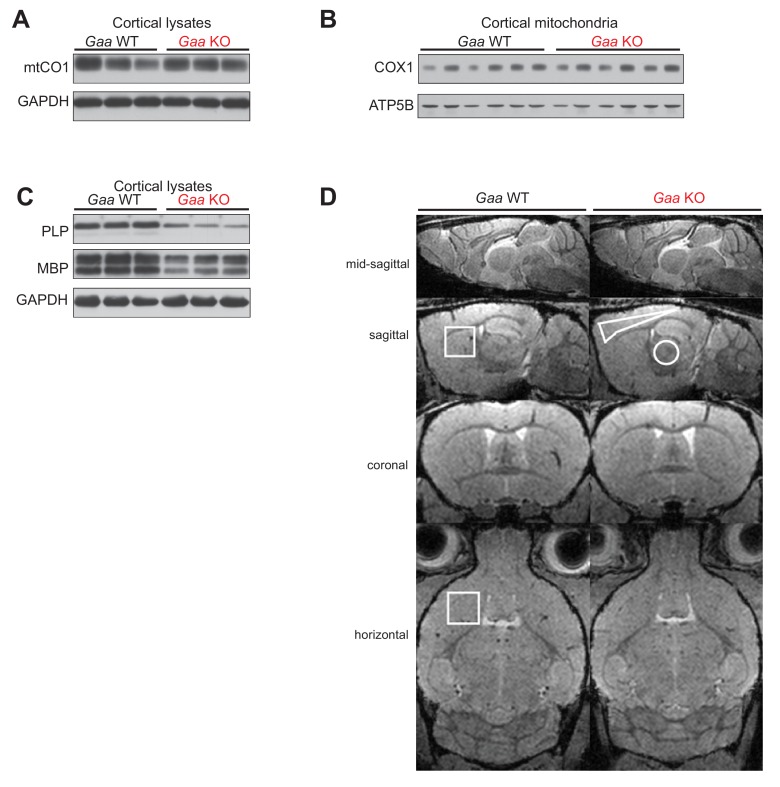
Steady state levels of COX1, PLP and MBP proteins, and in vivo MRI of mouse brain.(A) Immunoblots of COX1 in whole cortical lysates of Gaa WT and KO mice at 6 months of age. GAPDH is used as loading control (n = 8). (B) Western blots of COX in mitochondria purified from Gaa WT and KO mouse cortices at 6 months of of age. ATP5A is used as loading control (n = 5). (C) PLP and MBP immunoblots from whole cortical lysates of 6 month old Gaa-/- mice and their wild type littermates (n = 8). GAPDH is used as loading control. (D) MRI (RF-spoiled 3D FLASH, TR/TE = 22/7.7 ms, flip angle 10°, fat suppression 90°, 117 µm isotropic resolution) of the brain of a 6-month-old wild-type and (left column) a 6-month-old Gaa-/-mouse (right column). Images are acquired from the mid-sagittal section, the sagittal section 2.4 mm from the midline, a coronal section showing the anterior commissure, and a horizontal section. They show the volume- as well as the region-of-interest used for the evaluation of the striatum (squares), the cerebral cortex (polygon), and the thalamus.